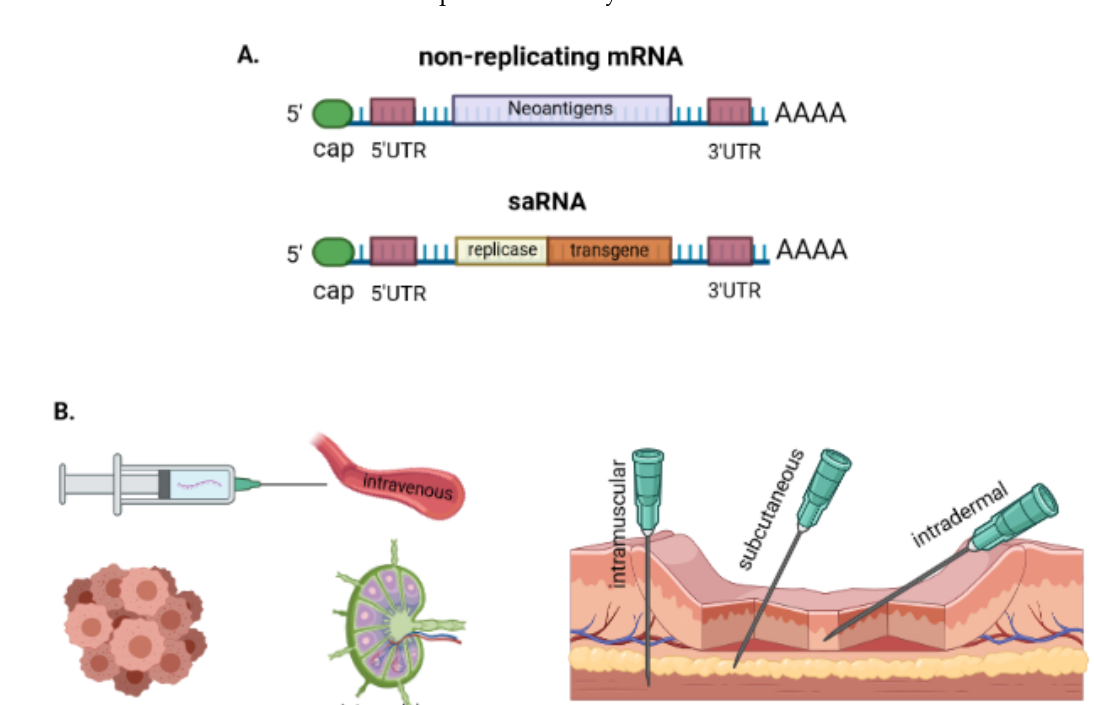
Figure 1. Non-replicating and self-amplifying mRNA ( A ) and administration routes of mRNA vaccines ( B ). saRNA encodes not only an antigen-encoding gene, but also a gene responsible for viral RNA replication [40]. saRNA, due to amplification of the RNA template in the